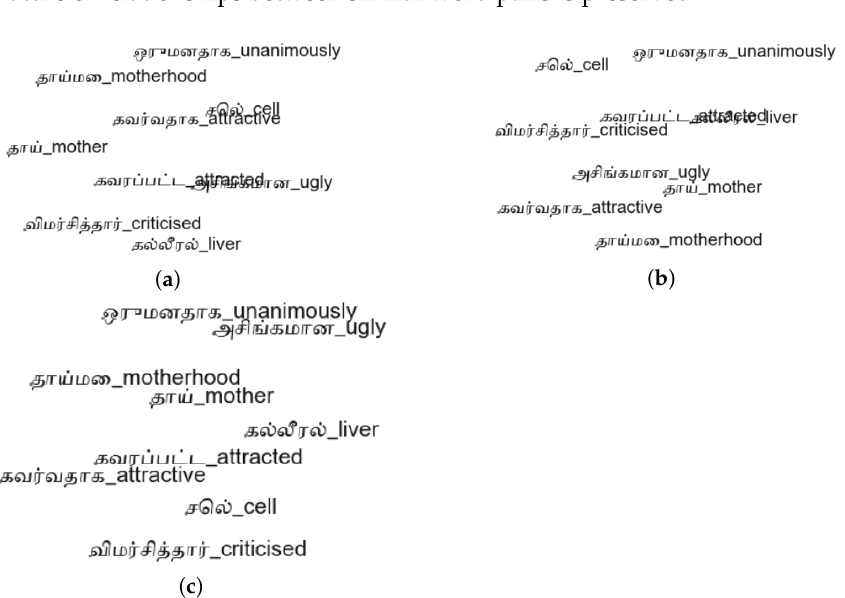
Figure 6. t-SNE visualization of transfer-learned Tamil vectors (MLP& CNN) and original vectors gen- erated by Word2Vec. ( a ) Original Embeddings; ( b ) Embeddings generated by MLP; ( c ) Embeddings generated by